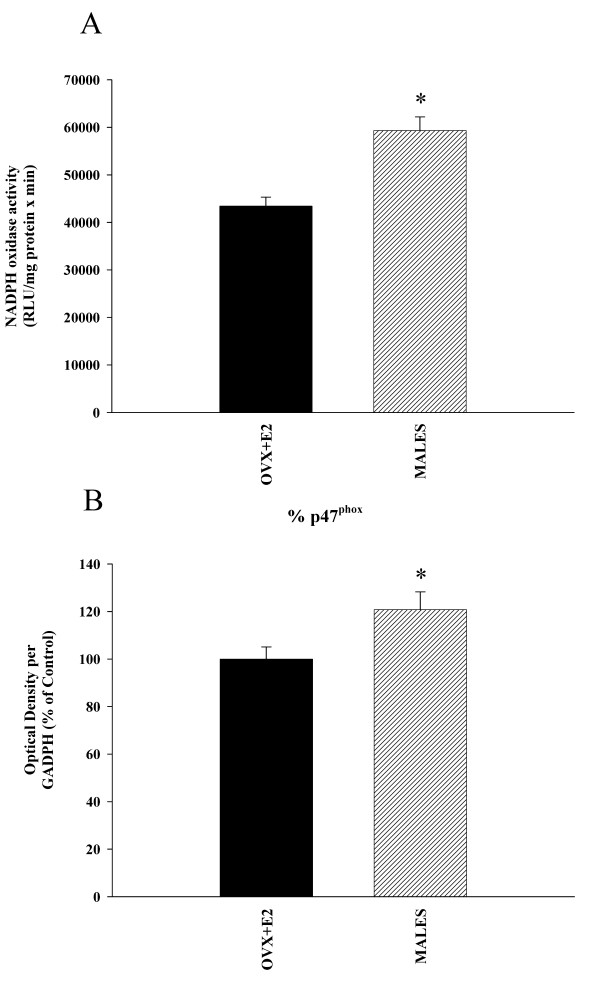
Activity of the NADPH oxidase complex in male and female rats. Lucigenin-enhanced chemiluminescence (A) and western blot (B) analysis of the NADPH complex activation in the ventral mesencephalon of males and female rats with estrogen (ovx +E2). Chemiluminescence analysis revealed significantly higher NADPH activity in males (A). Western blot analysis revealed that males had significantly higher expression of NADPH oxidase subunit p47phox (B). Data, expressed as relative light units (RLU/min/mg protein; A) and p47phox protein expression (B) was obtained relative to the GAPDH band value and then normalized to ovx+E2 values (100%). Data are means ± SEM. *p < 0.05 (Student's t test).